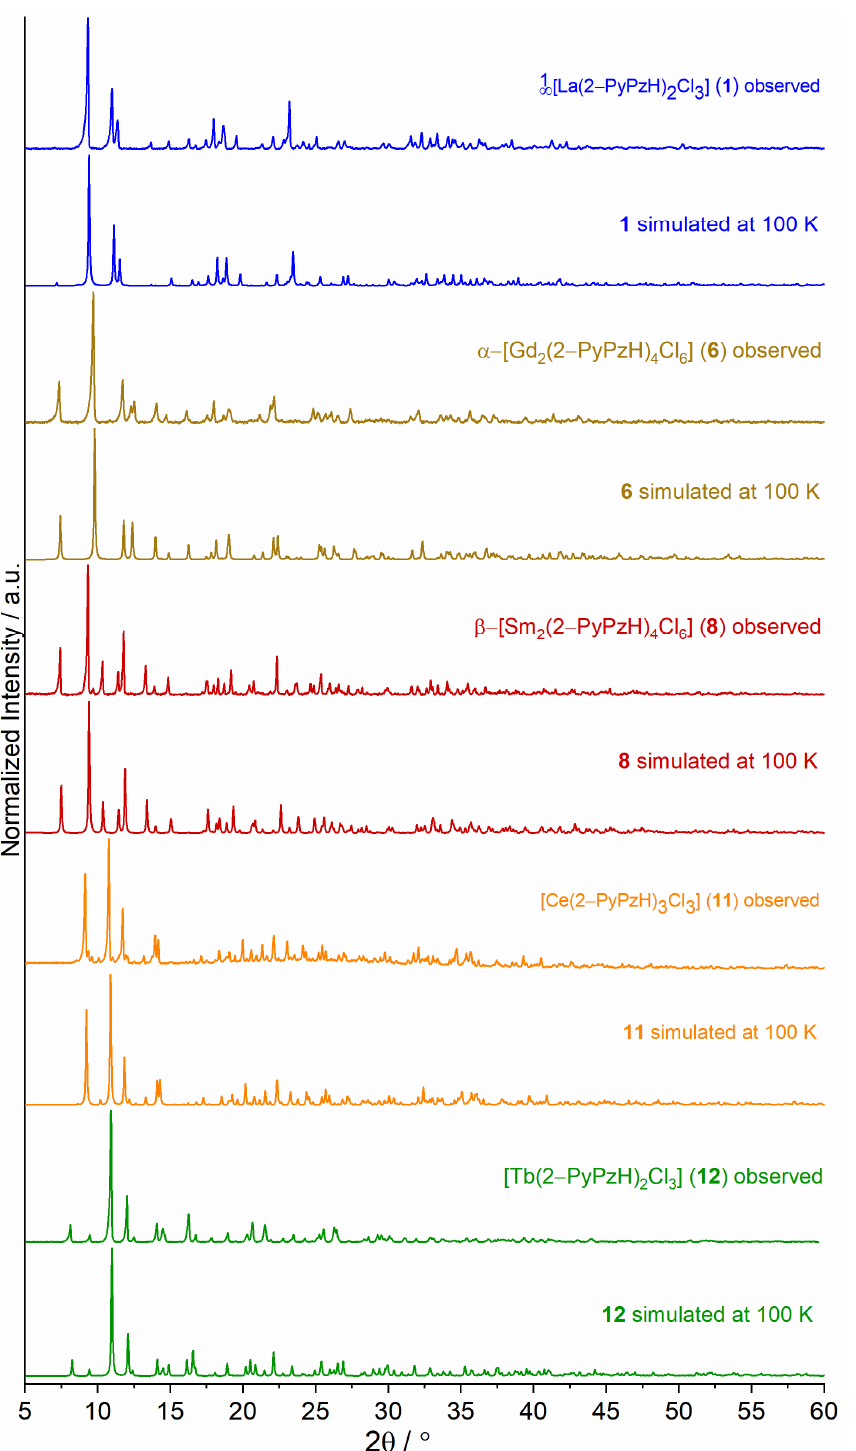
Figure 5. Comparison of exemplary experimental powder X-ray diffraction patterns of 1 ∞ [La 2 (2– PyPzH) 4 Cl 6 ] ( 1 ), α –[Gd 2 (2–PyPzH) 4 Cl 6 ] ( 6 ), β –[Sm 2 (2–PyPzH) 4 Cl 6 ] ( 8 ), [Ce(2–PyPzH) 3 Cl 3 ] ( 11 ), and [Tb(2–PyPzH) 2 Cl 3 ] ( 12 ) as representatives of their isotypic 1D-CPs and complexes with the respective simulated pattern from single crystal X-ray